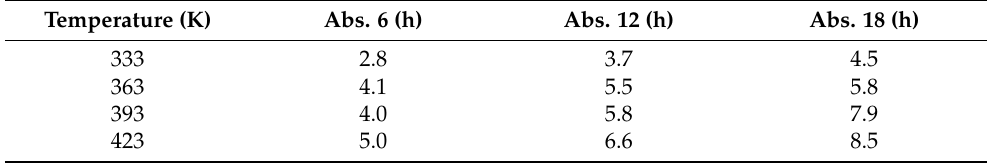
Table 6. Mass increasing rate of LiBO 2 at 333–423 K for the absorption time of 6–18 h. Temperature (K)